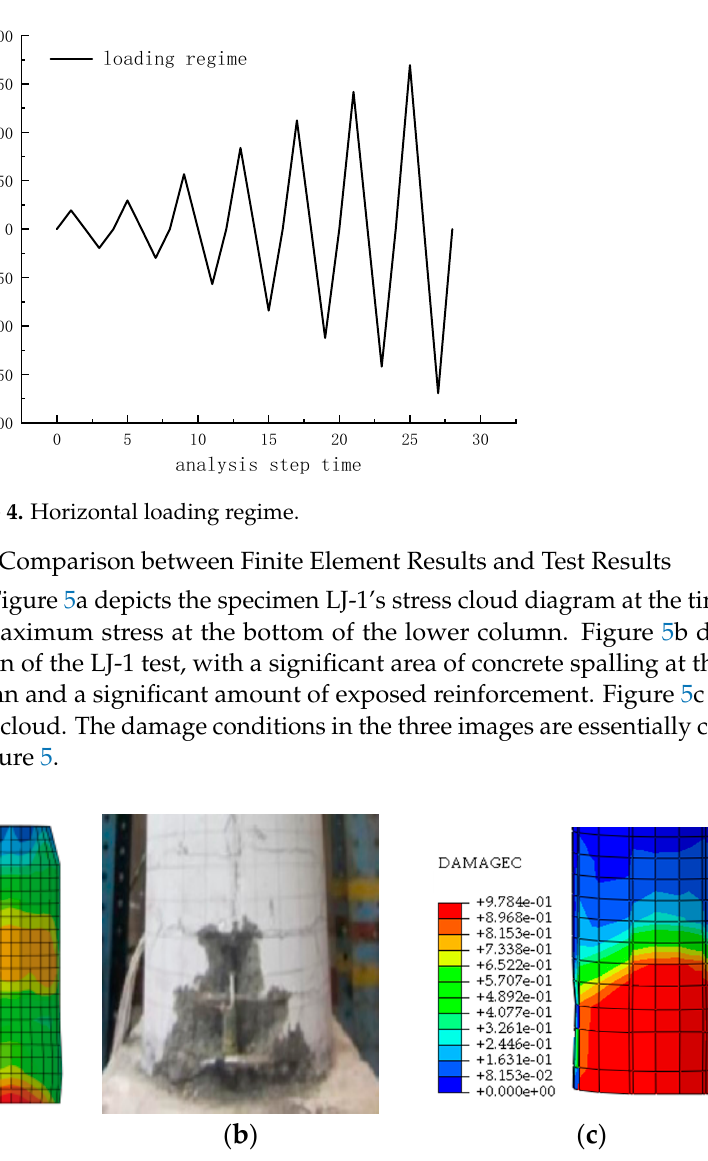
Figure 5. Simulation and test results comparison of Specimen LJ-1: ( a ) finite element stress cloud; ( b ) test damage pattern; ( c ) damage stress cloud.